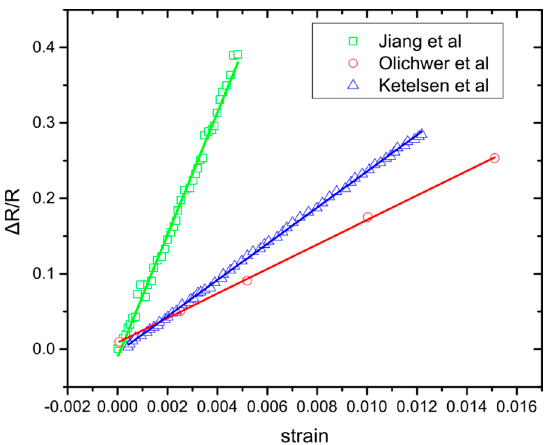
Figure 3. Relative resistance change over strain for different strain sensors based on cross-linked Gold nanoparticles Jiang et al. [41] Ketelsen et al. [39] and Olichwer et al. [42]. The continuous lines are the fitting of Equation (4).